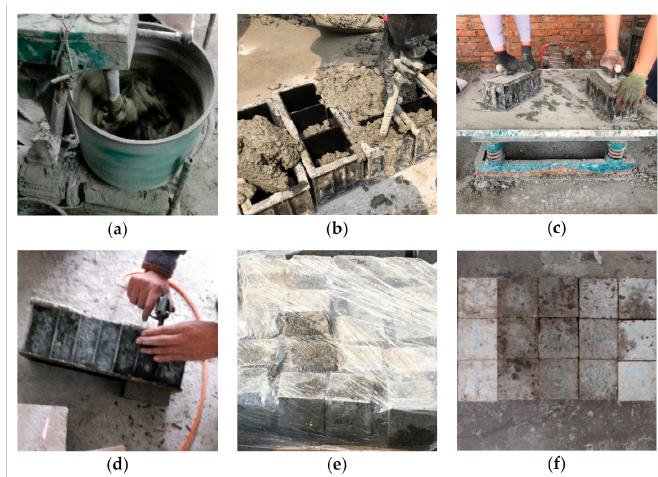
Figure 3. Preparation process of concrete cubic specimens: ( a ) Concrete mixing, ( b ) concrete pouring, ( c ) vibration compaction of concrete cubic specimens on vibration table, ( d ) demolding after 24 h, ( e ) maintenance of concrete cubic specimens, and ( f ) partial concrete cubic specimens after 28 days of maintenance. Table 4. Grouping of the cubic specimens for compression test. Rubber Particle Size Number of Number of Group and Content Specimens Compression